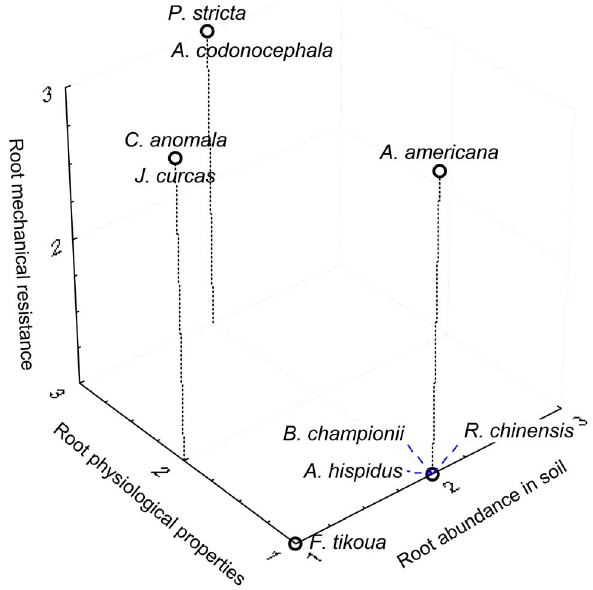
Figure 11. 3D diagram of species’ scores. Summary of species’ performance according to root abundance in soil, root mechanical resistance and root physiological properties.